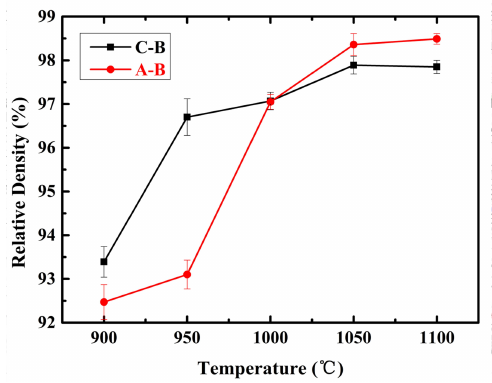
Figure 2. The relative densities of titanium-based metal matrix composites (TMCs) sintered at different